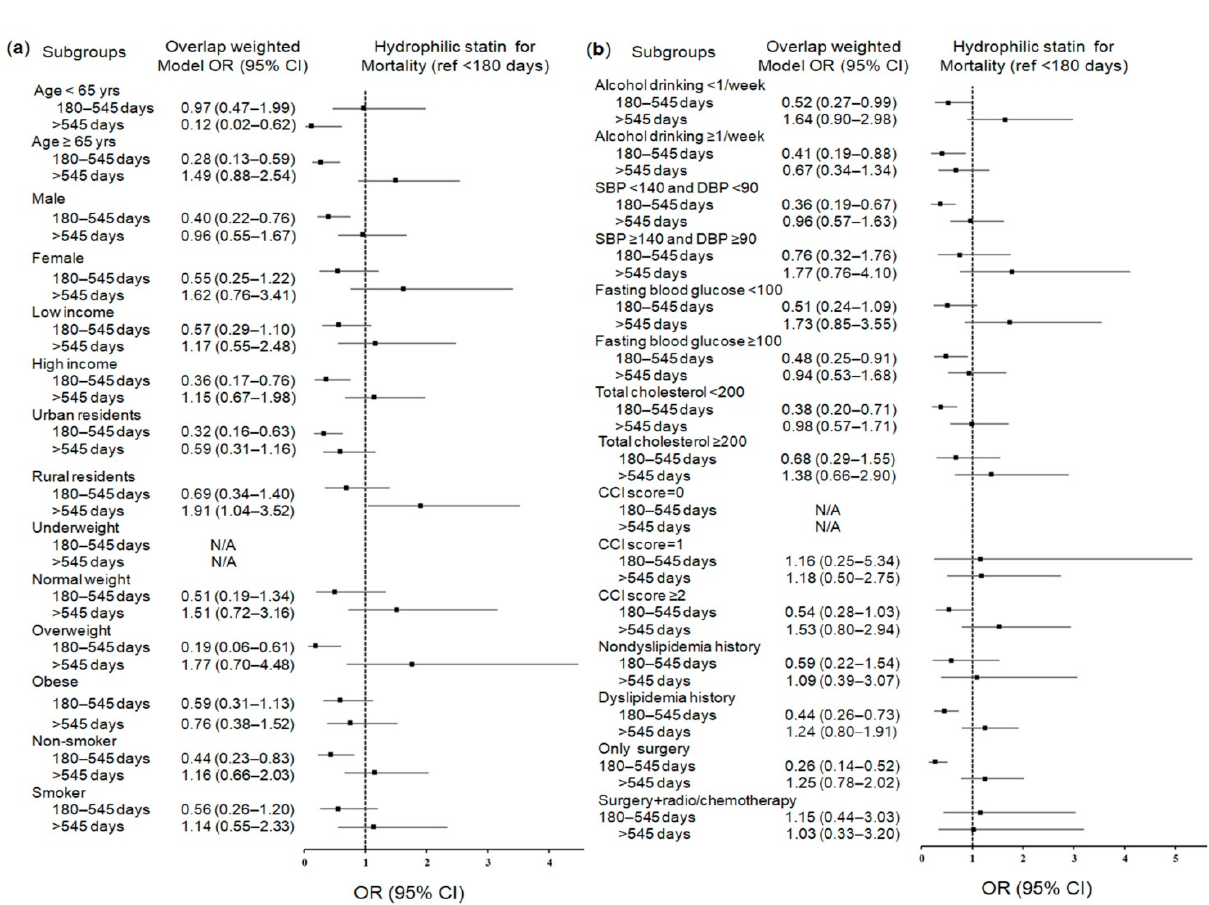
Figure 4. Forest plots for multivariable conditional logistic regression depicting the overlap weighted odds ratios (95% confidence intervals) of previous use duration of hydrophilic statins for overall mortality in the patients with incident gastric cancer according to comprehensive subgroup analyses, including age, sex, income, region of residence, obesity, and smoking ( a ), alcohol consumption, systolic blood pressure, diastolic blood pressure, fasting blood glucose, total cholesterol, CCI scores, and dyslipidemia history ( b ). The reference period is <180 days. Full results of the crude and adjusted overall weighted models are available in Supplementary Table S5 (hydrophilic statins).